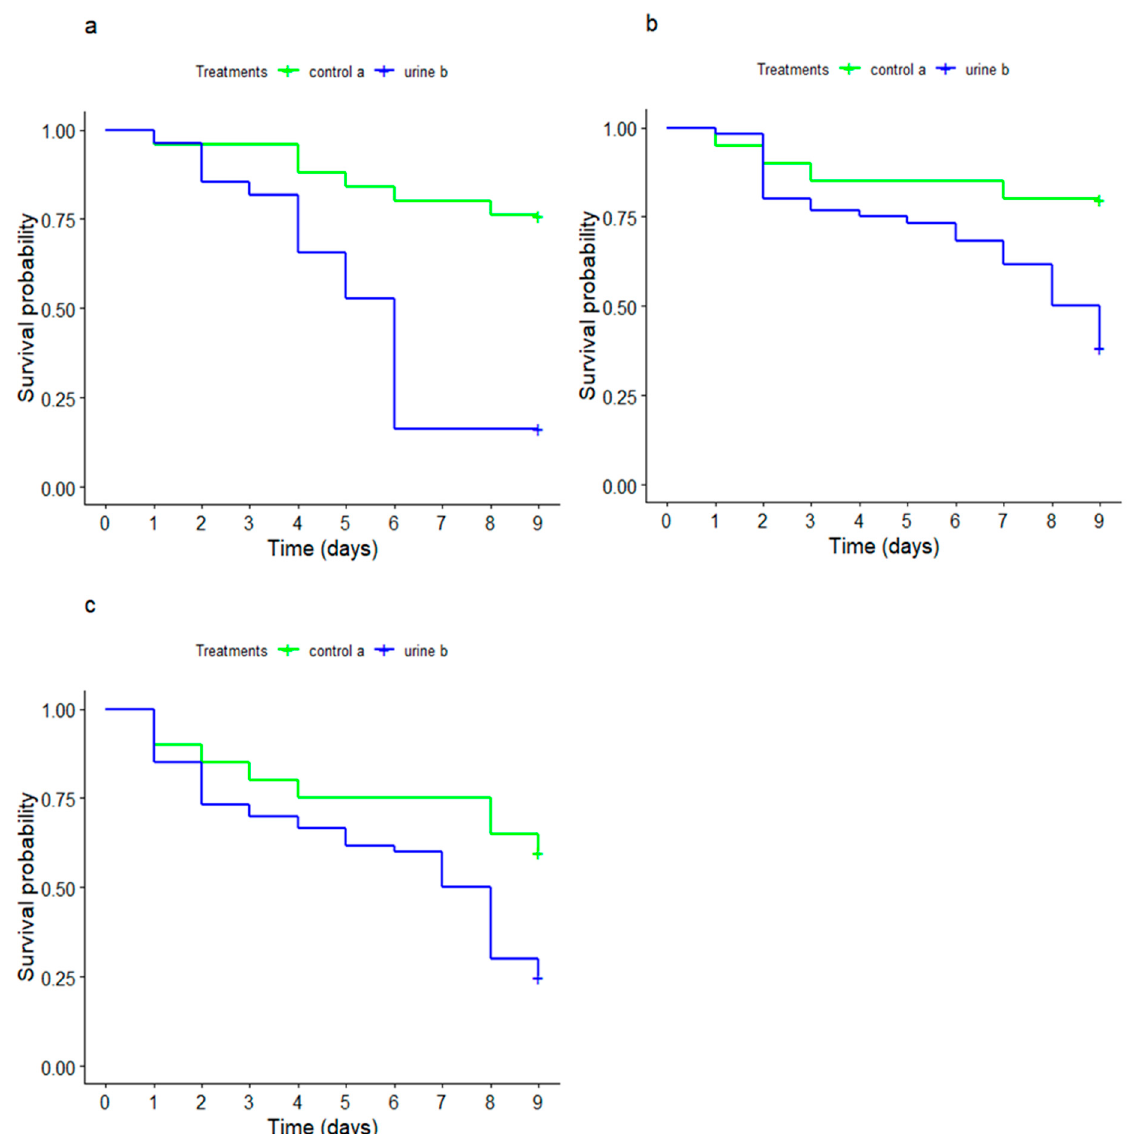
Figure 6. Kaplan–Meier survival distribution curves of the fall armyworm first instar larvae ( a ), second instar larvae ( b ) and third instar larvae ( c ) exposed to rabbit urine or distilled water (control). “+” indicates right censorship. Small letters after the legends indicate a significant difference between the control and rabbit urine treatments.